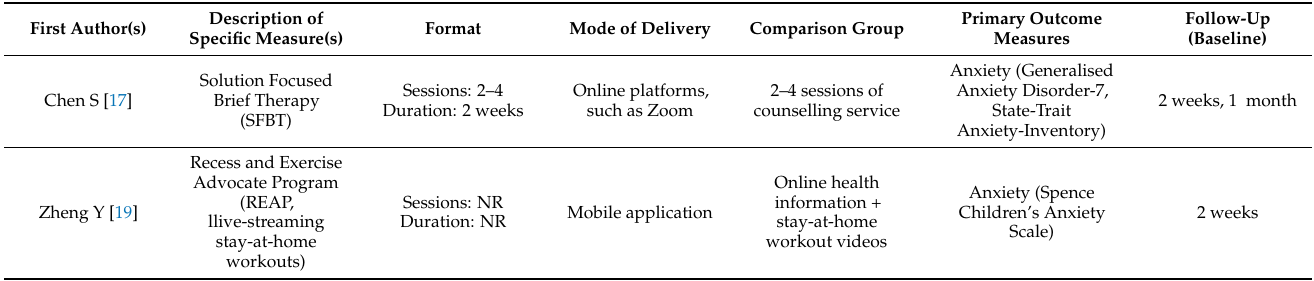
Table 3. Characteristics of